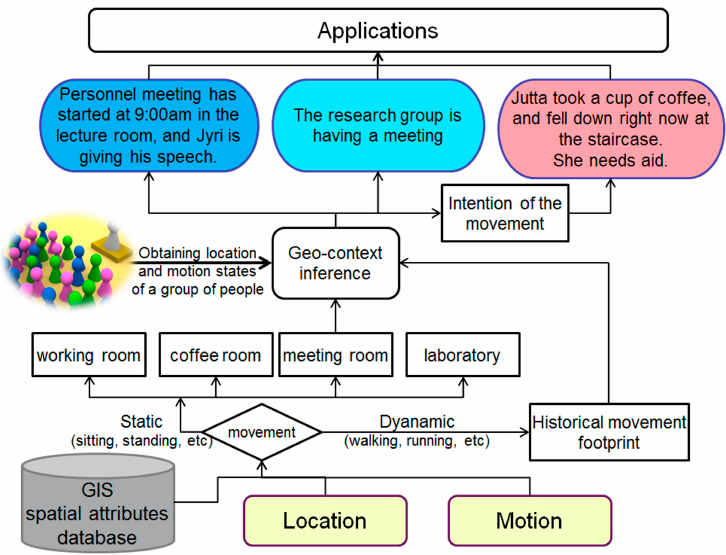
Figure 9. Flowchart of the geo-context computing solution and related